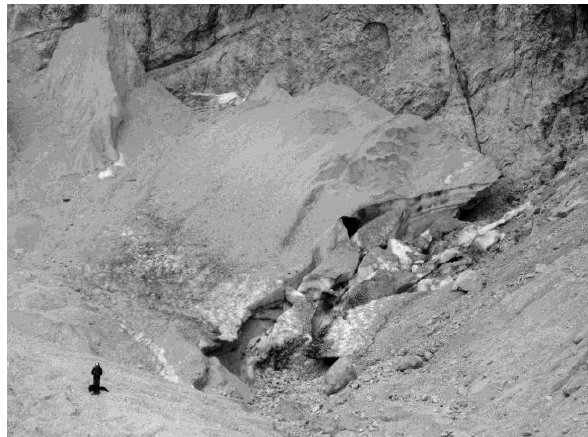
Figure 5. The collapsed area in the western portion of Montasio Occidentale glacier, at the starting zone of the small debris flow depicted in Figure 4 (photo S. Calligaro, 5 October 2012).